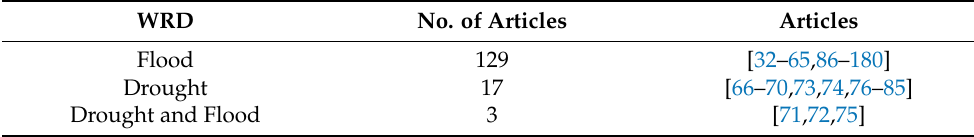
Table 6. Categorization of articles based on WRD